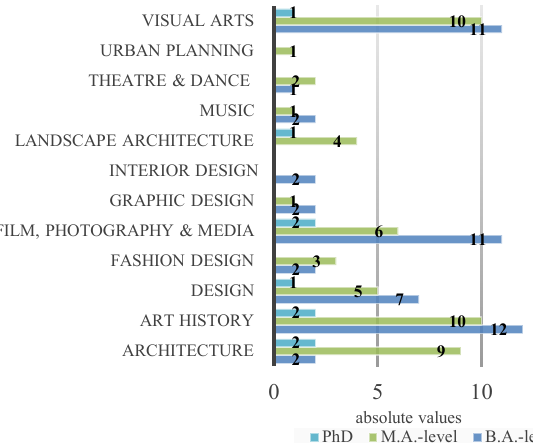
Figure 5. Domains of DCH in arts, design, and architecture pro-